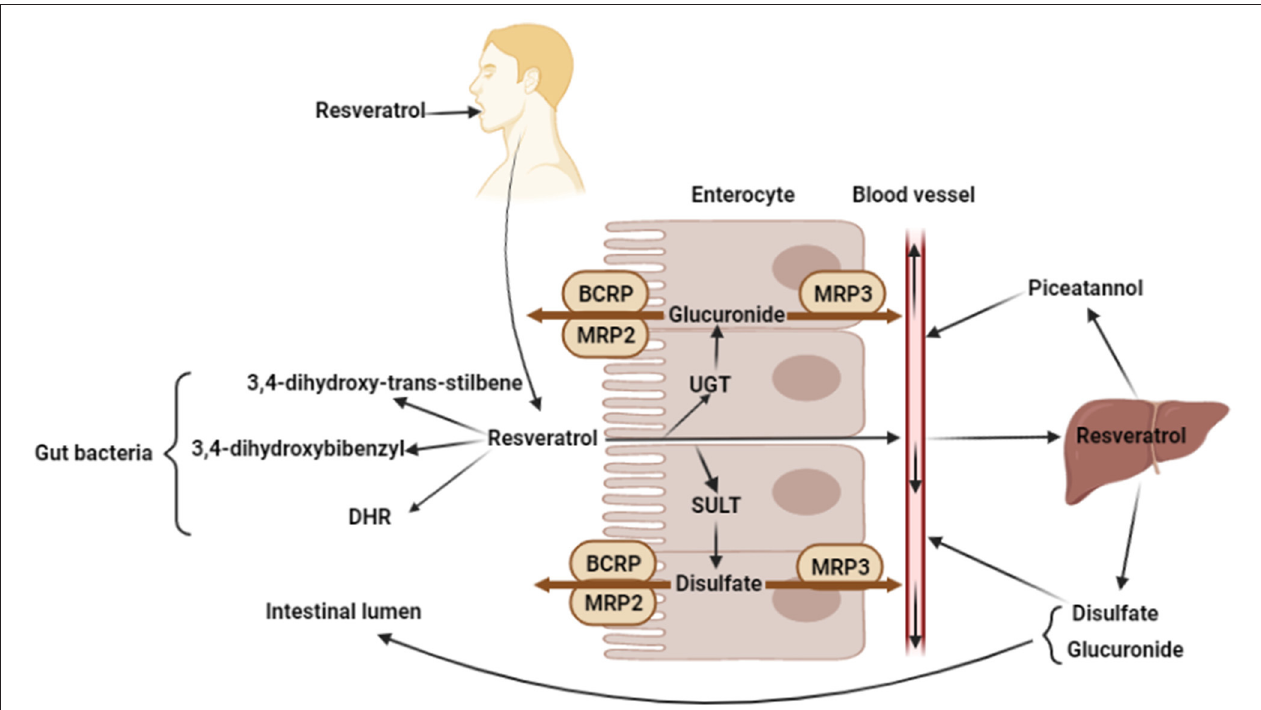
FIGURE 2 | Absorption and metabolism of resveratrol. Oral resveratrol reaches the intestine and enters the enterocytes through passive diffusion. A small part of resveratrol can directly enter the blood circulation, while most resveratrol produces glucuronide and disulfate by the UDP-glucuronosyltransferases (UGT) and sulfotransferases (SULT) in enterocytes, and glucuronide and disulfate are transported back to intestinal lumen by the ABC transporter of enterocyte apical membrane (BCRP, MRP2), or transported into bloodstream by the ABC transporter of enterocyte basolateral membrane (MRP3). In addition, resveratrol produces 3,4-dihydroxybibenzyl, 3,4-dihydroxy-trans-stilbene, and dihydroresveratrol (DHR) by microorganisms. And in liver, resveratrol is metabolized to produce piceatannol, disulfate and glucuronide. The figure was created with